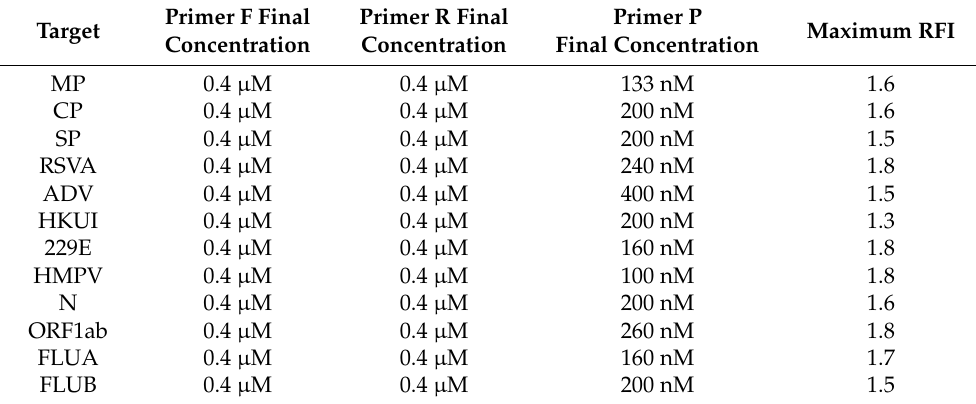
Table 2. Final concentration of primers and probes used in the